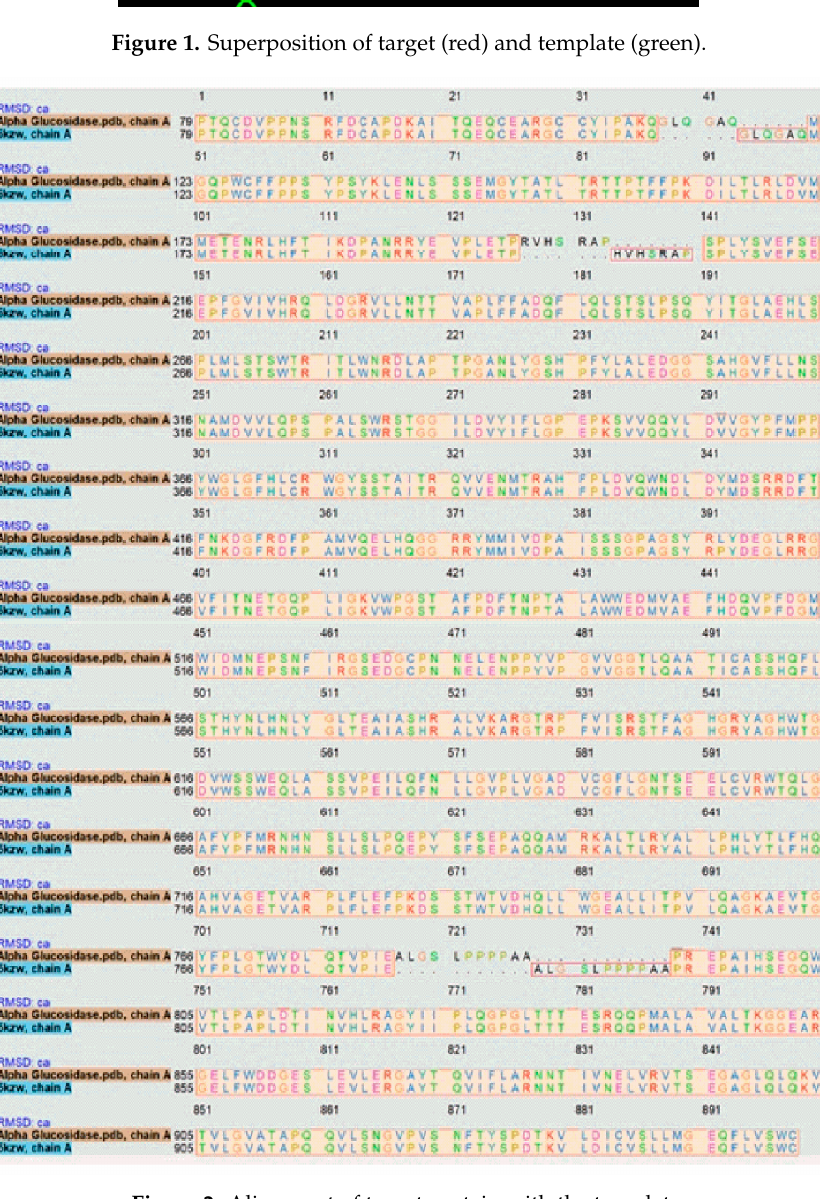
Figure 2. Alignment of target protein with the template.